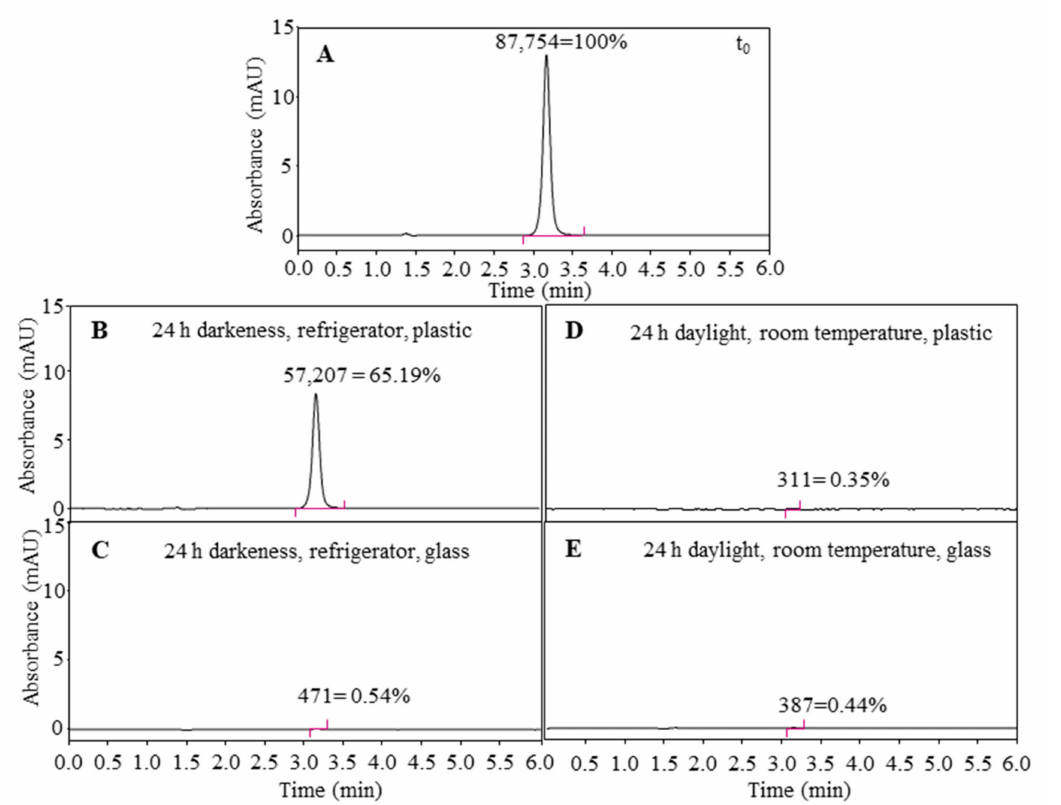
Figure 3. Ascorbic acid (aq) (50 µ M) analyzed immediately after preparation ( A ) was subjected to 24 h of aging ( B – E ), stored in the refrigerator and protected from light ( B , C ) in plastic ( B ) and glass containers ( C ) or stored in daylight at room temperature ( D , E ) in plastic ( D ) and glass containers ( E ). The peak areas corresponding to ascorbic acid ( t R 3.1 min, 254 nm) in aged solutions were compared to the peak area of ascorbic acid in the fresh solution. The intermediate precision of the method was 3% ( n =